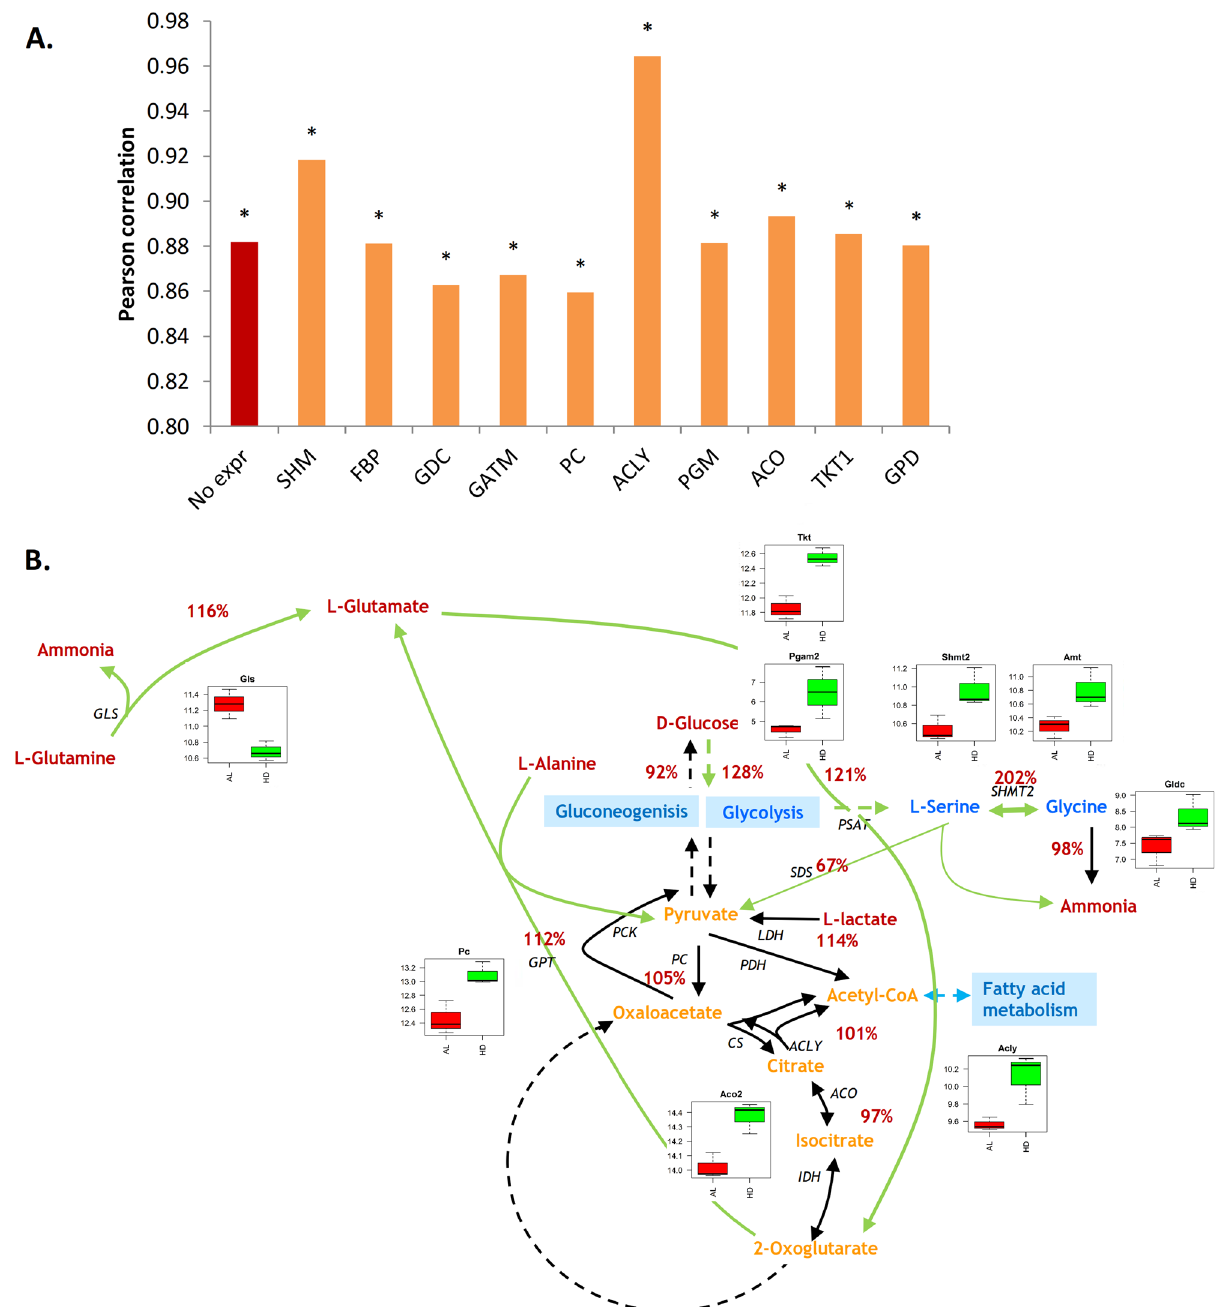
Fig. 4 Effect of gene expression alterations on fl ux predictions in HD. A Pearson correlation coef fi cients between measured and predicted exchange fl uxes. The objective in all simulations in this fi gure is ammonia. The reactions on the x axis — SHM, FBP, etc. — represents the effect of overexpression of the respective genes on the predicted fl uxes and the resulting Pearson correlation with the measured exchange fl uxes. The asterisk * indicates signi fi cance. B Relative changes in predicted fl uxes (%) for activity of SHM and AMT genes in all pathways. Boxplots show the gene expression levels of signi fi cantly altered genes in the